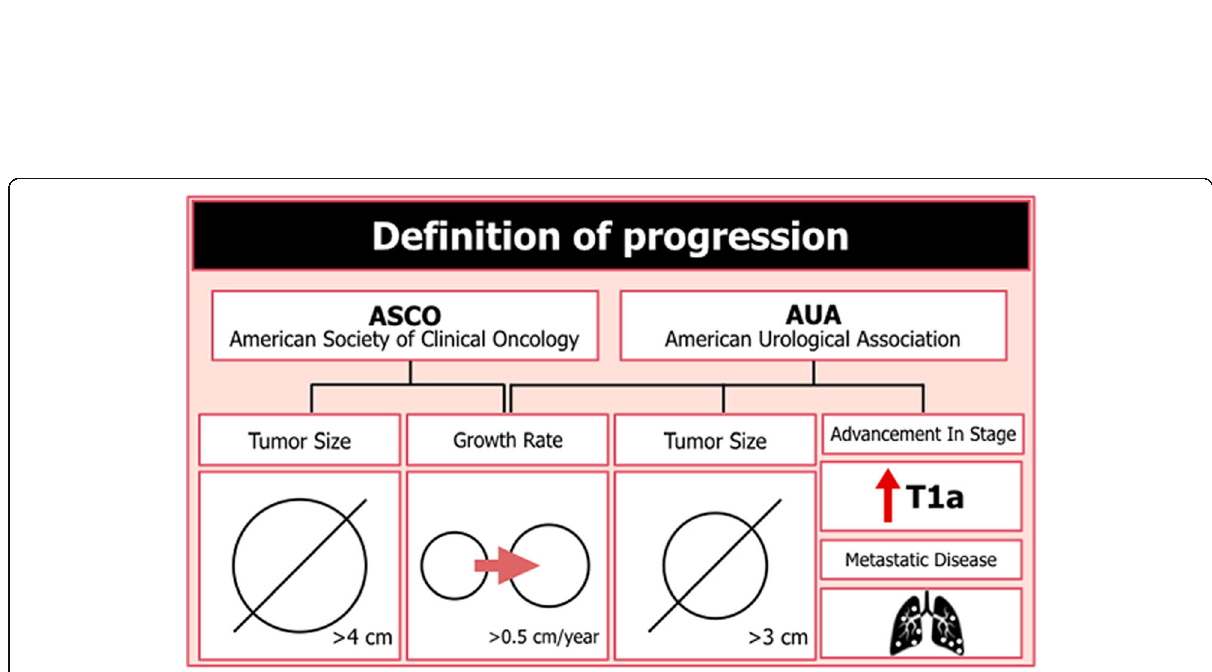
Fig. 13 Definition of active surveillance progression according to the American Society of Clinical Oncology (ASCO) and American Urological Association (AUA)